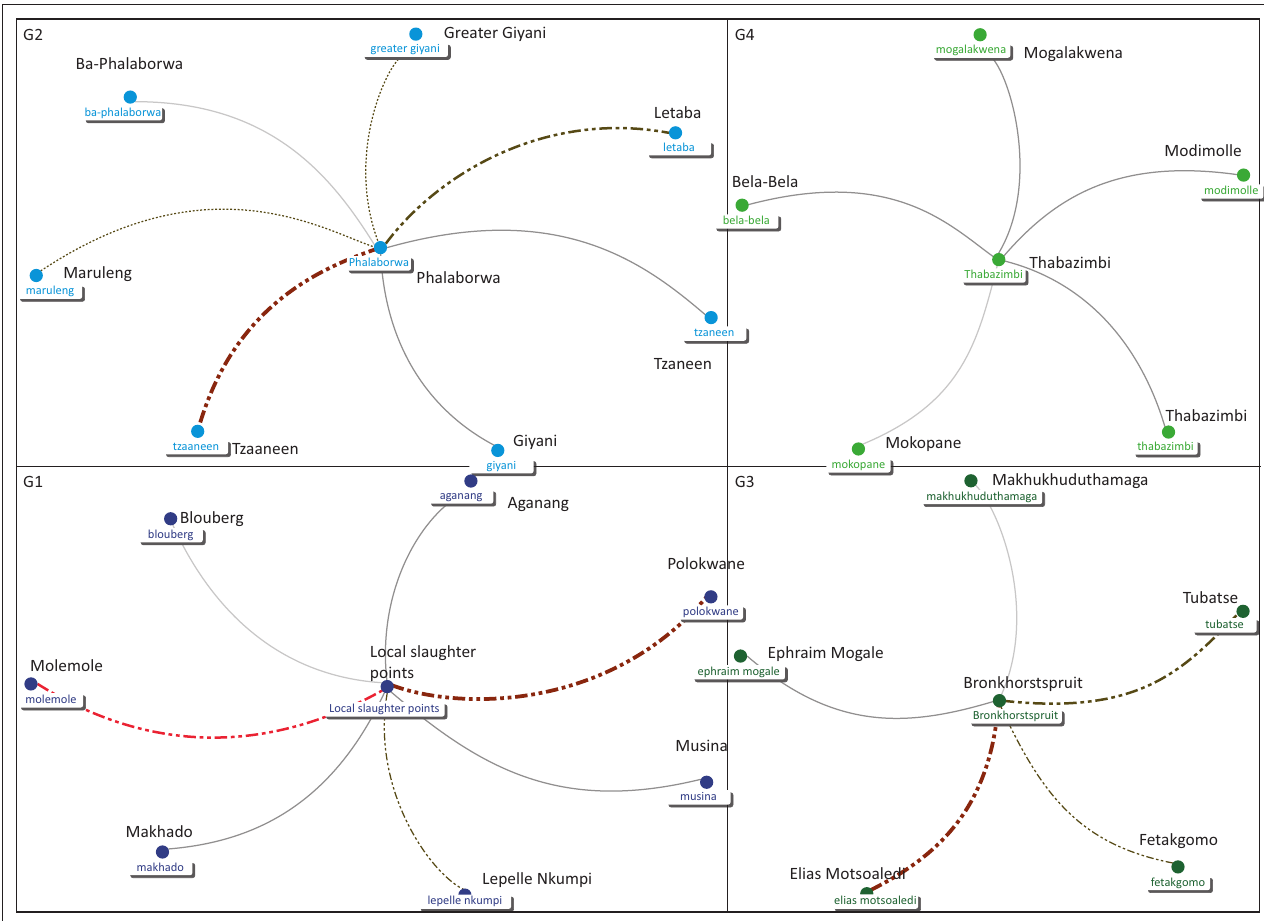
FIGURE 4: Network map of connected locations for emerging small-scale pig farmers in